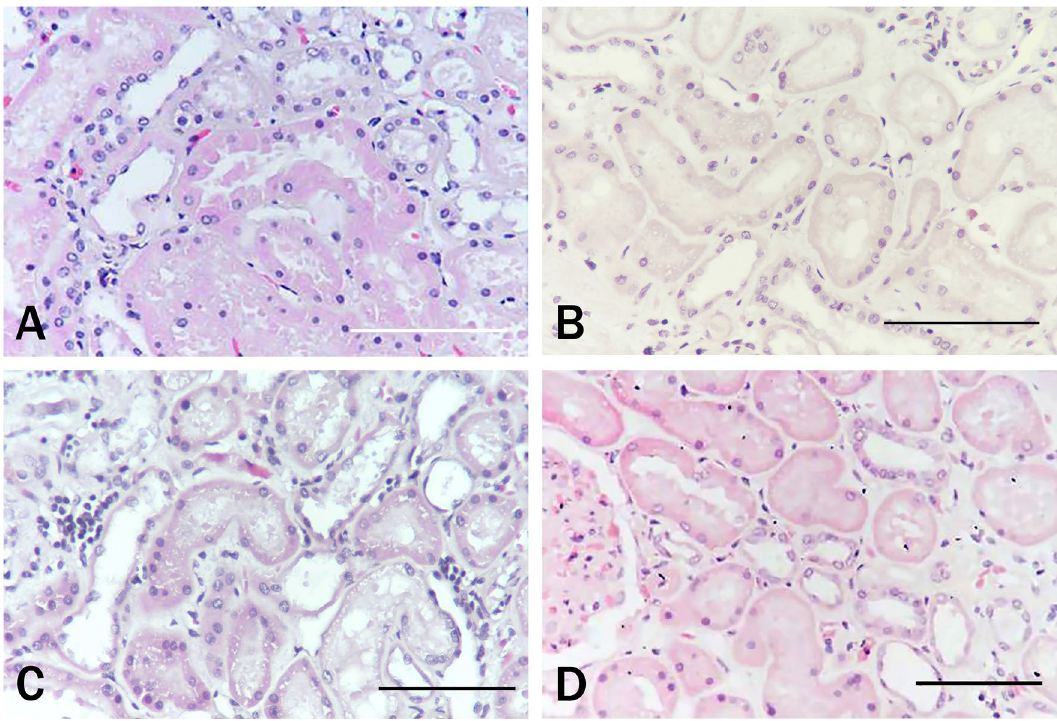
Figure 2. Comparison of normal control renal tissues treated with 1% TCCA for 15 min under different HE staining conditions: ( A ) untreated control, conventional HE staining; ( B–D ) HE staining after 1% TCCA treatment: ( B ) conventional HE staining; ( C ) extended time HE staining; ( D ) restored pH HE staining. Scale bar means 100 μm.